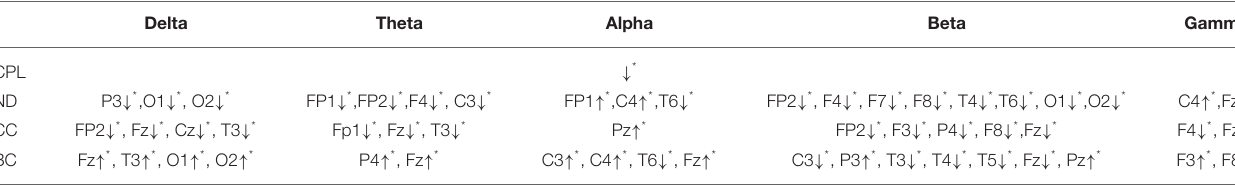
TABLE 3 | Characteristics of brain networks in different frequency bands of IS between the WNS and SNS stages. Delta Theta Alpha Beta